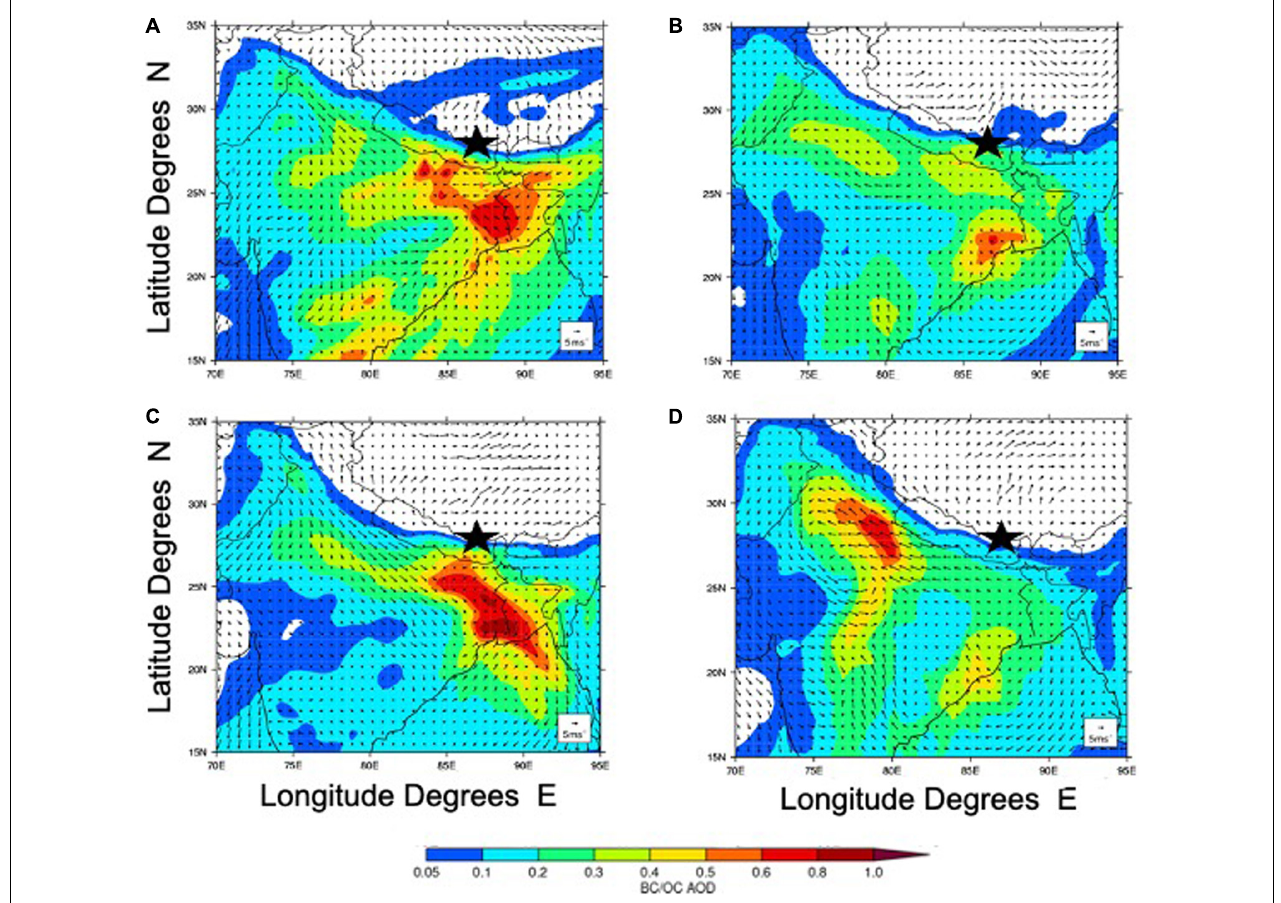
FIGURE 4 | NAAPS Model Results of Black Carbon/Organic Carbon (BC/OC) Aerosol Optical Depth (AOD) and 850 hPa wind (vectors) over South Asia over the study period. (A) 20 January 2016, (B) 27 January 2016, (C) 31 January 2016, and (D) 07 February 2016. The Dudh Koshi River Basin is denoted with a *Aerosol optical depth is